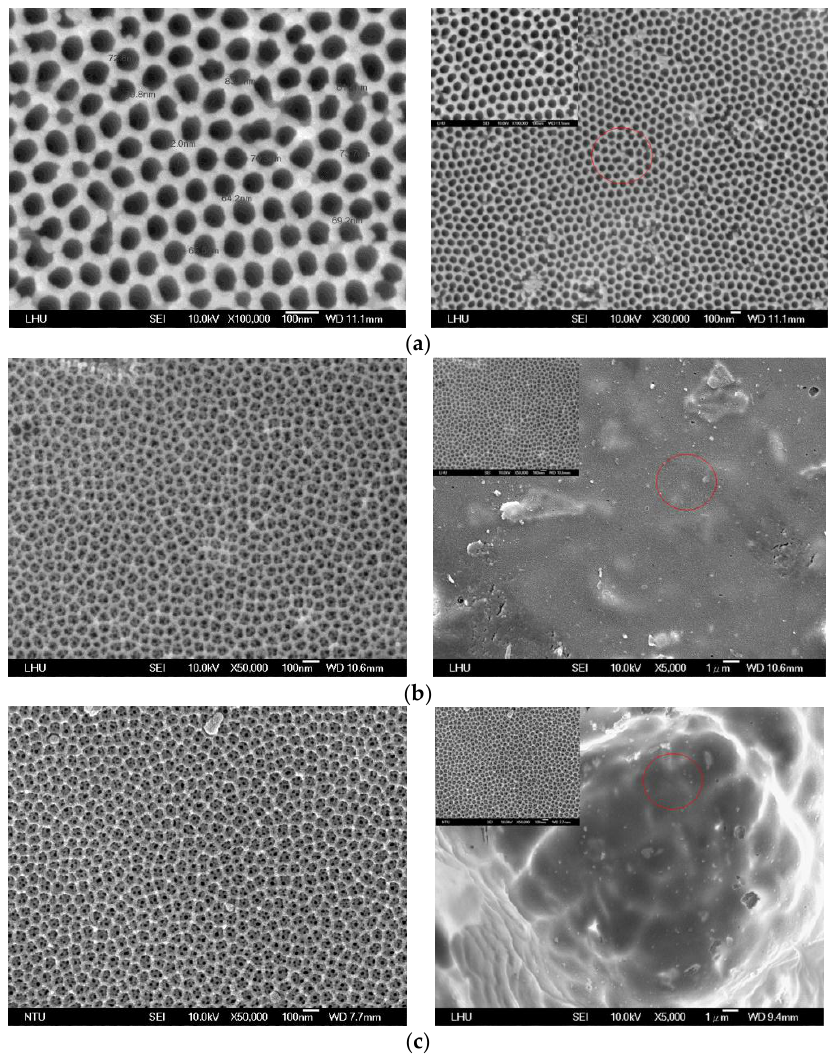
Figure 3. SEM images of nano-structure and micro/nano-structure: ( a ) Φ = 100 nm (anodic aluminum oxide (AAO)); ( b ) Φ = 60–80 nm (nano-hole on micro/nano-structure with electrolysis polishing); ( c ) Φ = 50–80 nm (nano-hole on micro/nano-structure, without electrolysis polishing).